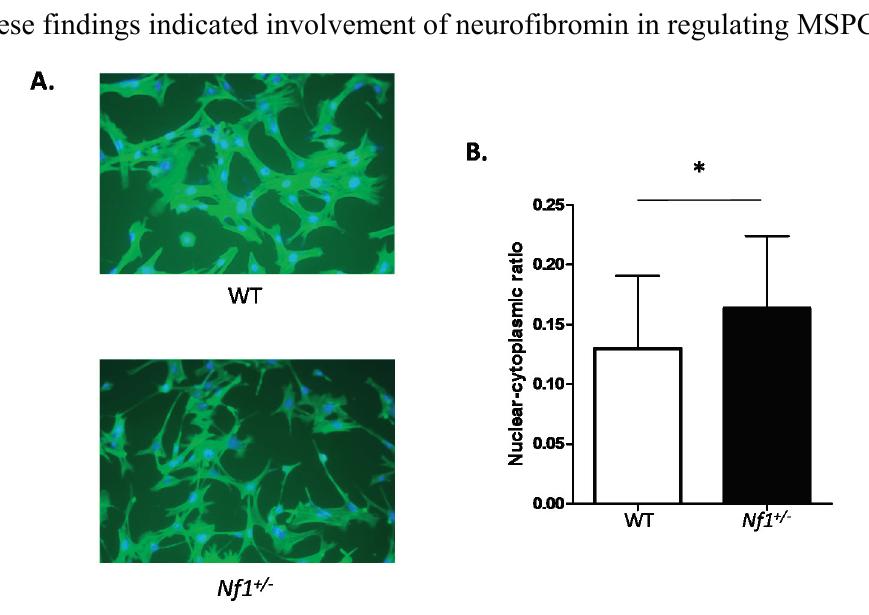
Figure 1. Morphological differences between wild-type (WT) and Nf1 haploinsufficient ( Nf1 +/ − ) mesenchymal stem/progenitor cells (MSPCs). ( A ) Morphology of WT and Nf1 +/